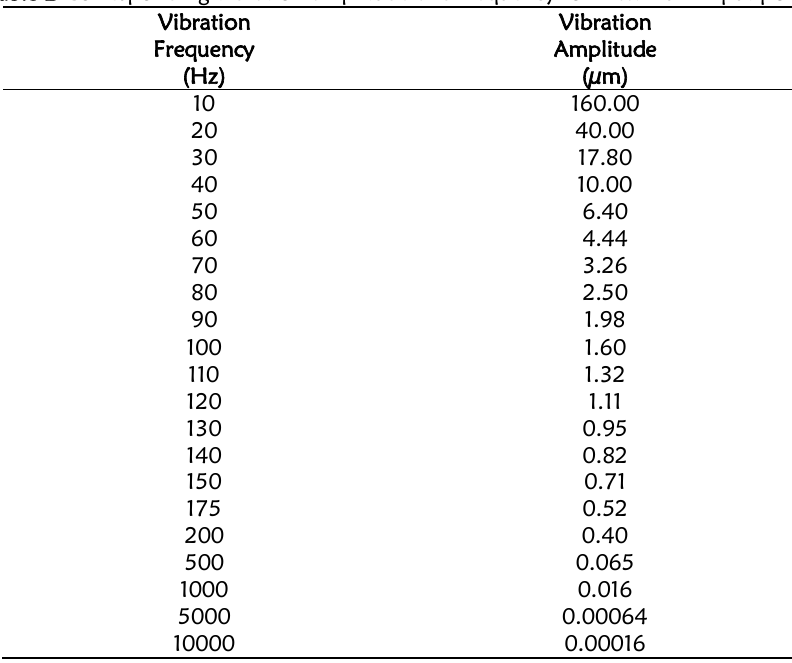
Table 2 Corresponding vibration amplitude and frequency for maximum input